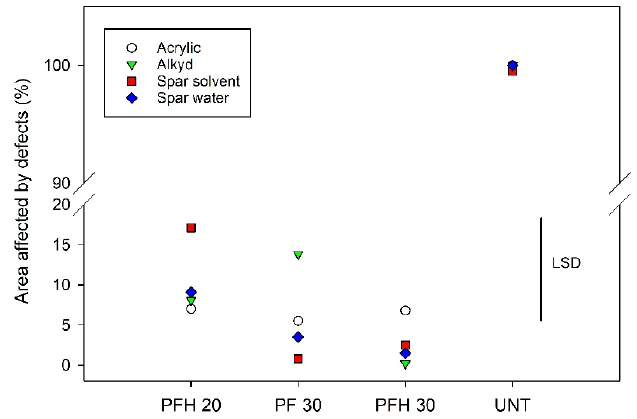
Figure 7. Levels of coating defects in treated and untreated radiata pine panels after 4 years’ exposure to the weather.